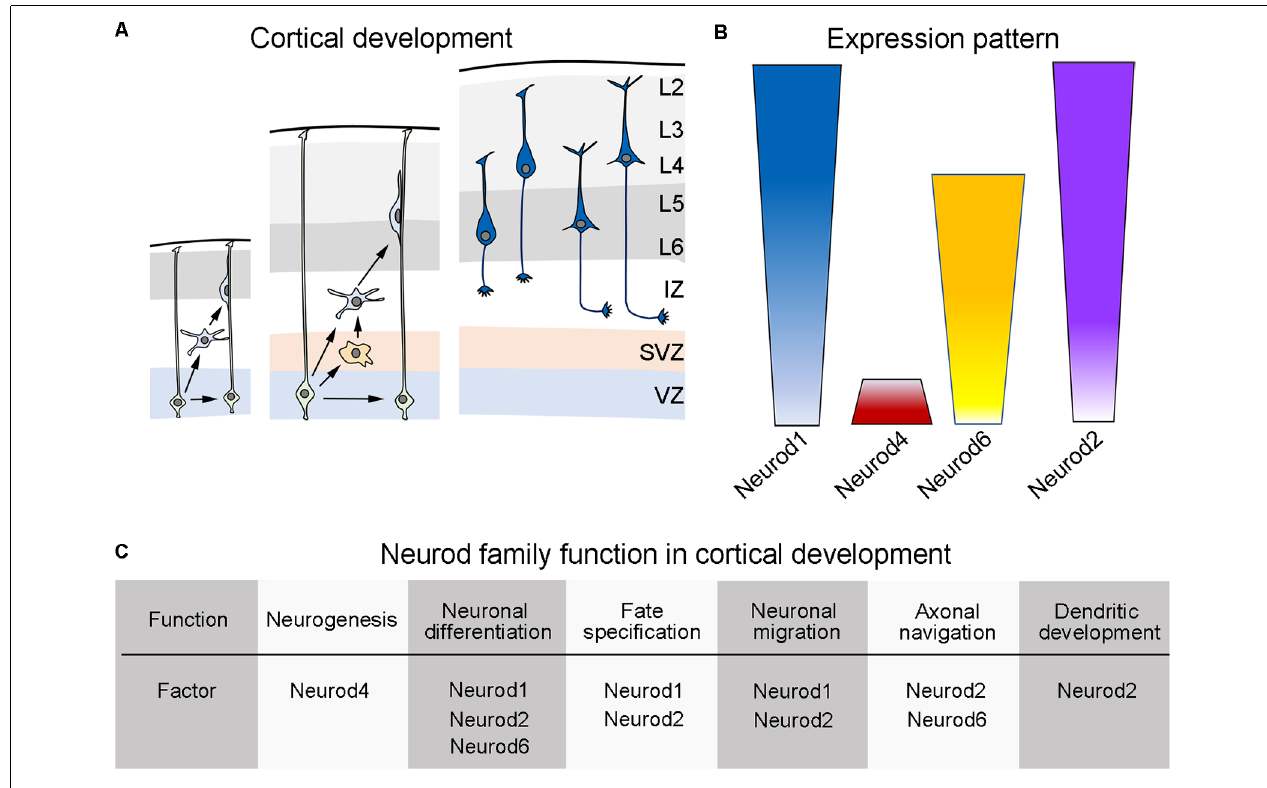
FIGURE 1 | Developmental expression of the Neurod family during cortical development of mice. (A) Schematic representation of the cortical development in mice. (Left) During early cortical development, neural progenitor cells (light green, also called radial glial cells) located in the dorsal ventricular zone (VZ) make early decisions as to self-renew or differentiate into early born neurons (light blue). (Middle) As cortical development progress, neuronal progenitor cells increase their choices and can then self-renew or differentiate into more committed progenitors (light orange) that populate an emerging subventricular zone (SVZ) or into differentiated neurons (light blue). Upon differentiation, neurons radially migrate throughout an intermediate zone (IZ) in order to populate the developing cortical plate (gray areas), using radial glial fibers as a scaffold. (Right) According to the time of birth, cortical pyramidal neurons (dark blue) settle into their appropriate cortical layer and start the elaboration of dendritic trees and the elongation or their axonal processes (see text). (B) Schematic display of the expression pattern exhibited by the different members of the Neurod family during cortical development (see text). (C) Table summarizing the known functions of the different members of the Neurod family during cortical development (see text). Panel (A) is inspired from Guo et al.